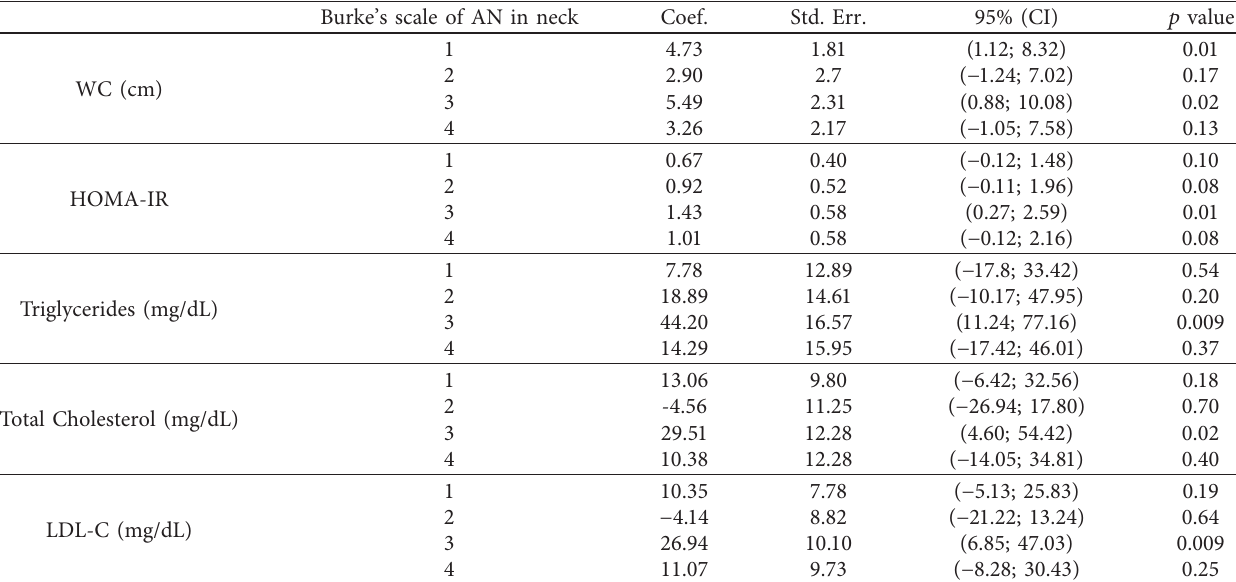
Table 2: Association of severity degree of an in neck by Burke’s scale with WC, HOMA-IR, and lipid profile in obese children. Burke’s scale of AN in neck